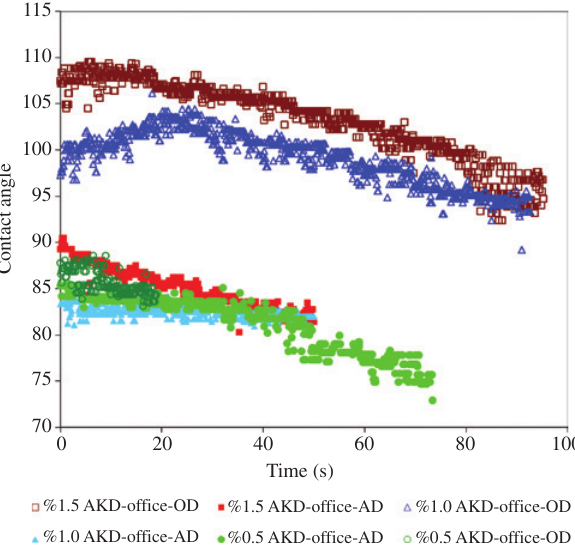
Figure 1: Contact angles (degrees) of both air- and oven-dried office